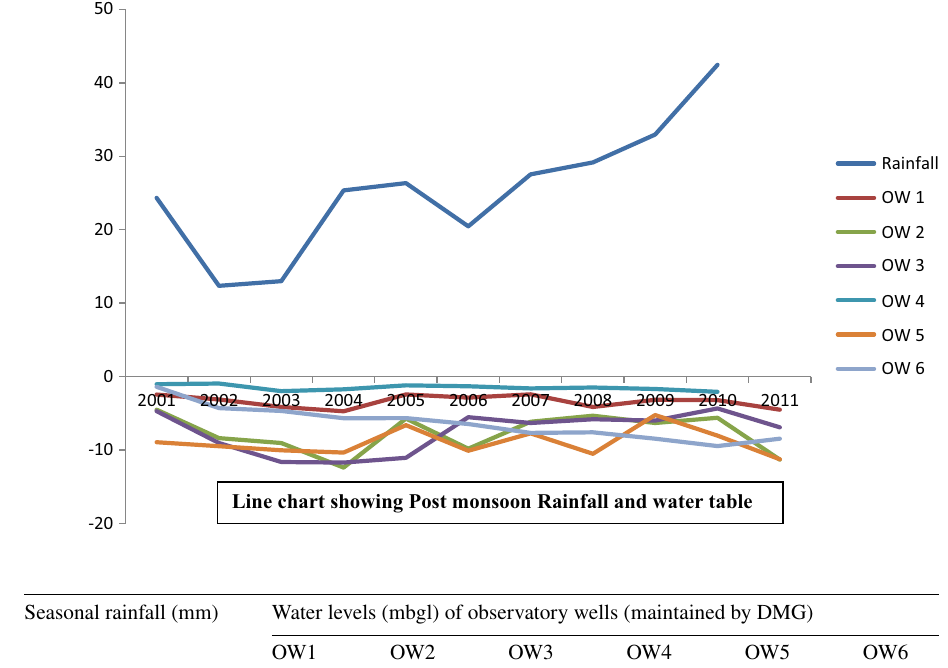
Seasonal rainfall